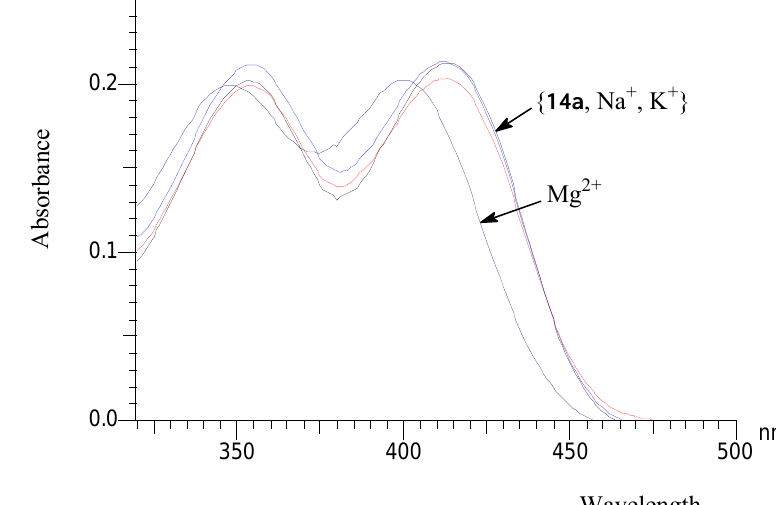
Figure 3. UV-Vis absorption spectra of free 14a and 14a in the presence of K + , Na + or Mg 2+ ion in CH CN 3